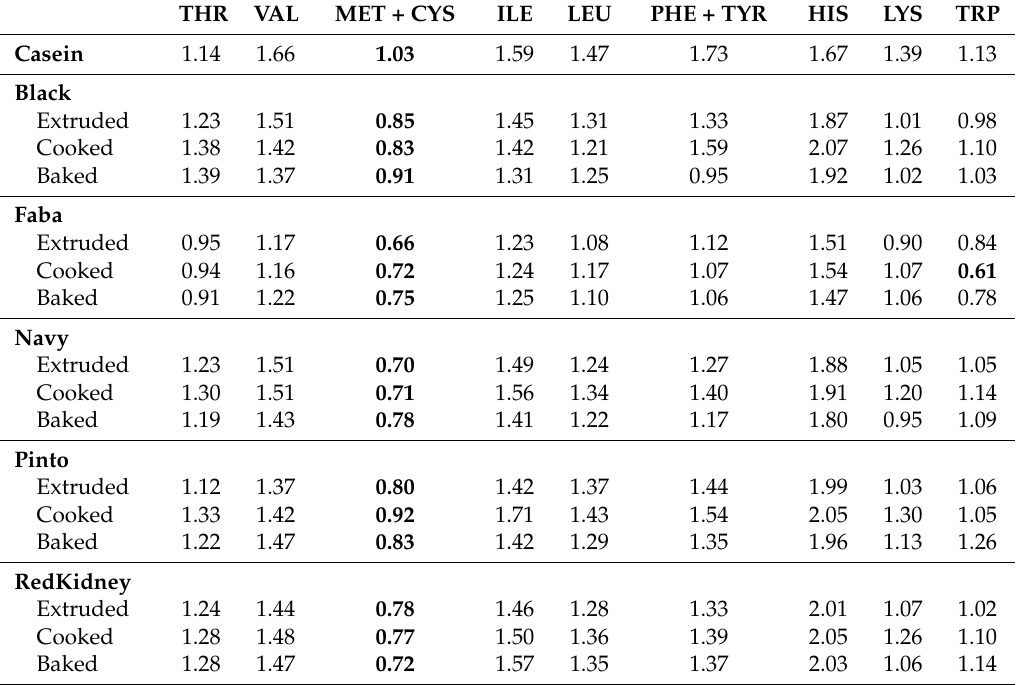
Table 3. Amino acid score of extruded, cooked and baked